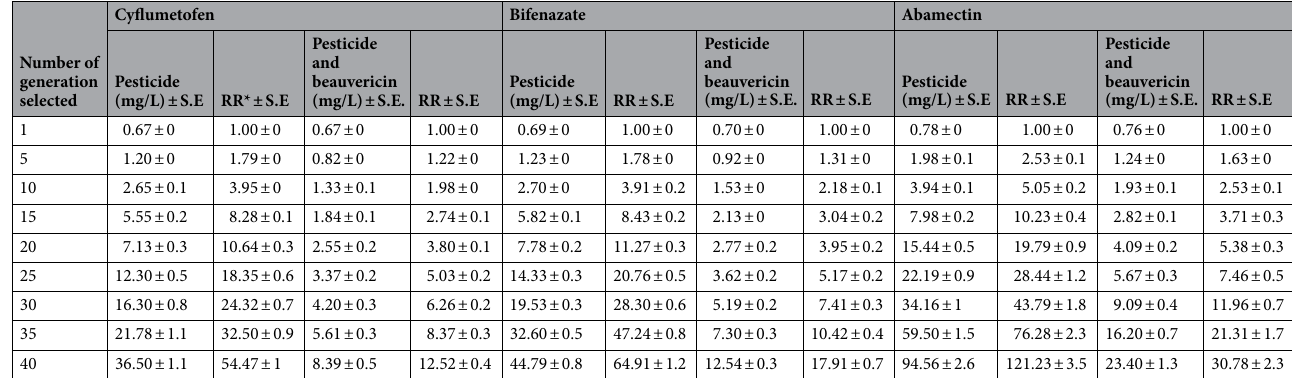
Table 3. Concentration probit mortality data of cyflumetofen, bifenazate, and abamectin (alone or in combination with beauvericin) against T. urticae with calculated resistance ratio. *RRs were determined by dividing the LC50 value of TSM-LB x (x being the number of generation) by the LC50 value of TSM-LB 1 (LR-TSM).